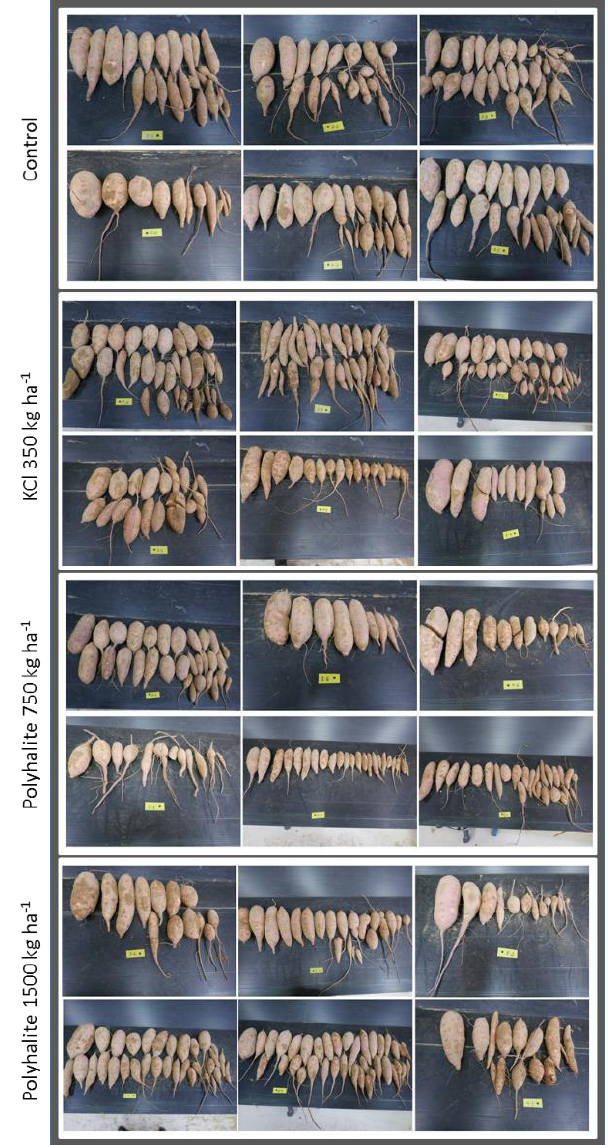
Figure 1. Lack of uniformity in sweet potato. Storage roots (SRs) were collected at mid-growth—100 days after planting, following a preplanting application of fertilizers: KCl at 350 kg ha −1 , or polyhalite at 750 or 1500 kg ha −1 . Each treatment and the control were designed in six replicates and arranged in random blocks. Each frame represents a block, and demonstrates SRs collected from 1 m of the bed. The figure presents SRs collected from the plot with the loess soil and demonstrates the variability in SR number and size, irrespective of treatment. A similar phenomenon was obtained in the sandy